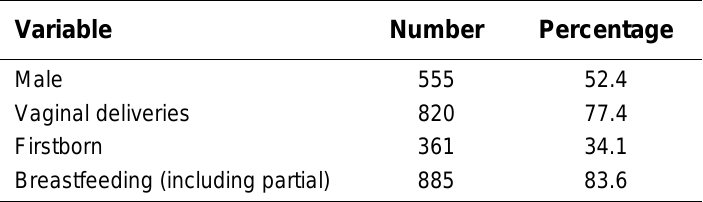
Demographic Variables of Study